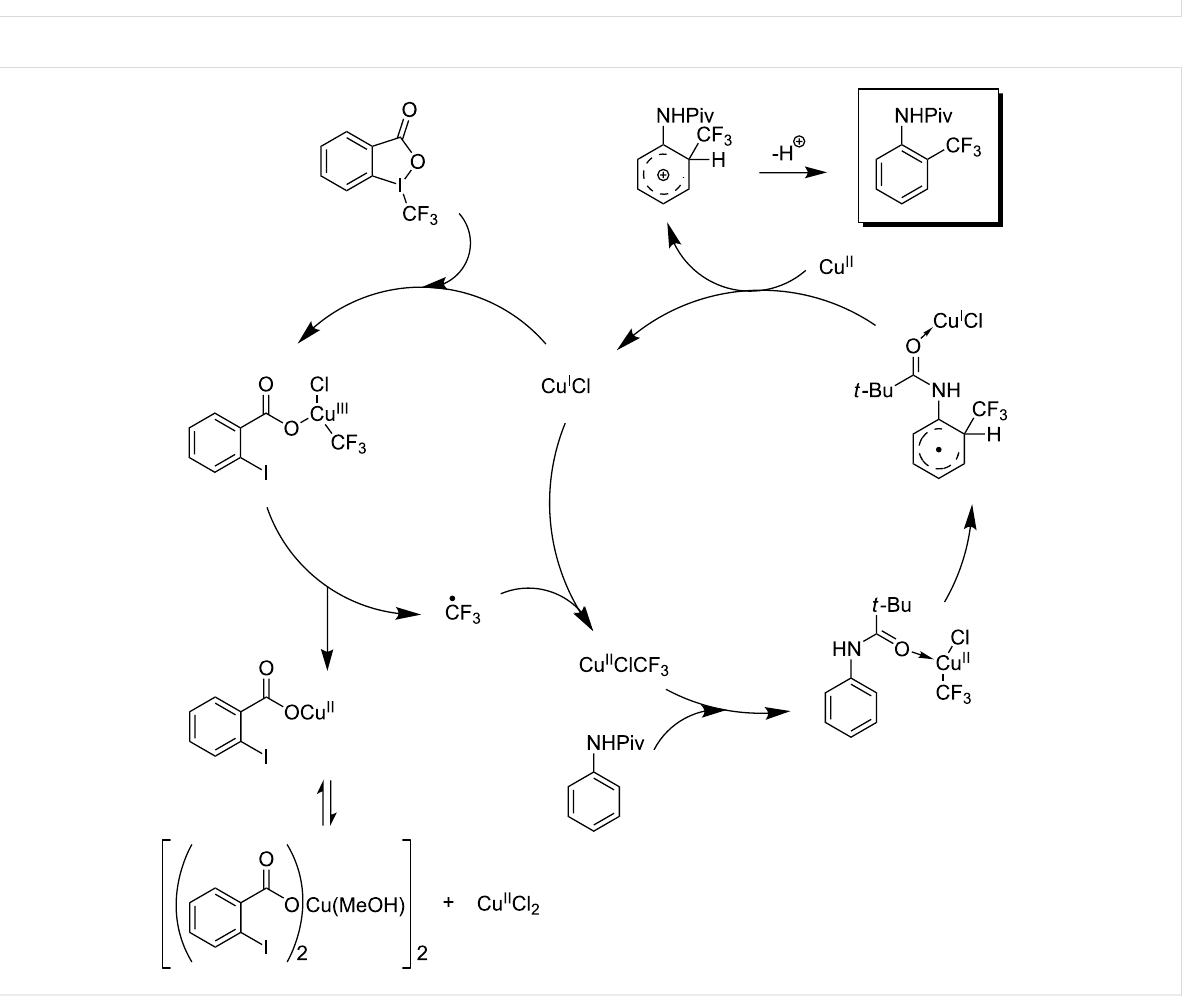
Figure 6: Proposed catalytic cycle for the copper-catalyzed trifluoromethylation of (het)arenes in presence of a pivalamido group (C. Chen, C. Xi et al.)